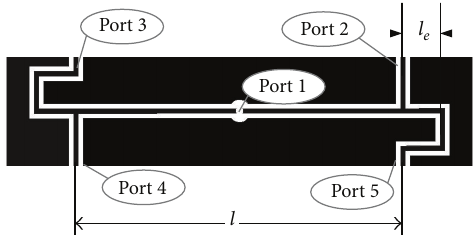
Figure 2: Structure of central coplanar waveguide.